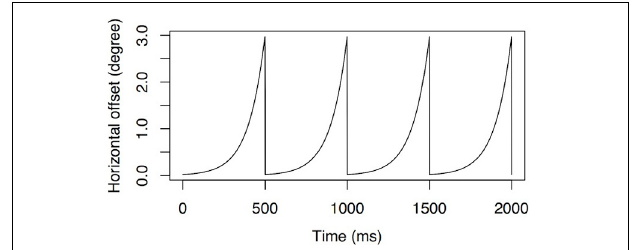
FIGURE 6 | Simulated nystagmus waveforms. An accelerating velocity exponential slow phase with amplitude of 3 ◦ of visual angle at